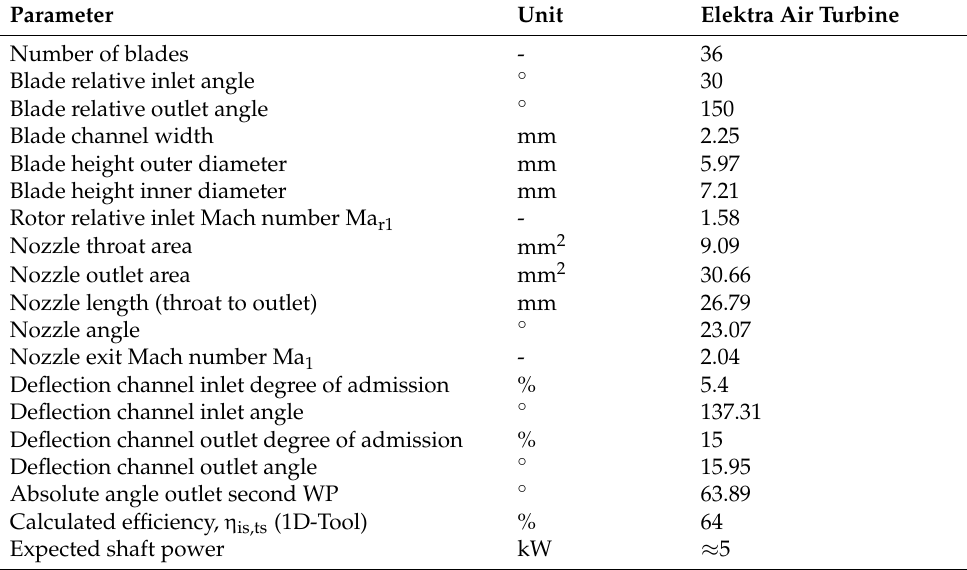
Table 4. Important characteristics of the investigated Elektra turbine resulting from the